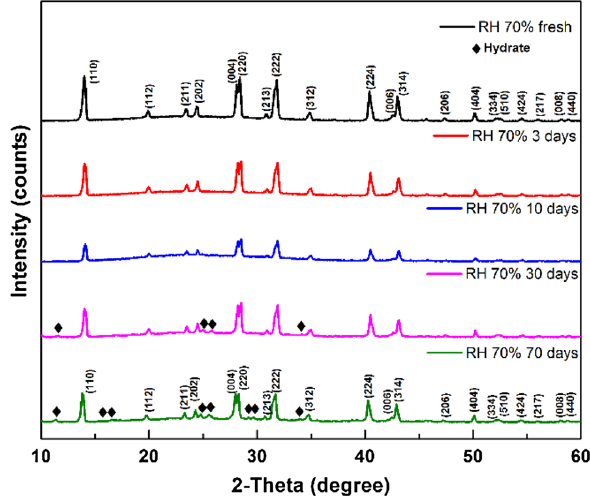
Fig. 1 XRD patterns of fresh perovskite film and stored at RH 70 % for 3, 10, 30, and 70 days. The hydrate phase is present for the film at 30 days and increases slowly for 70 days